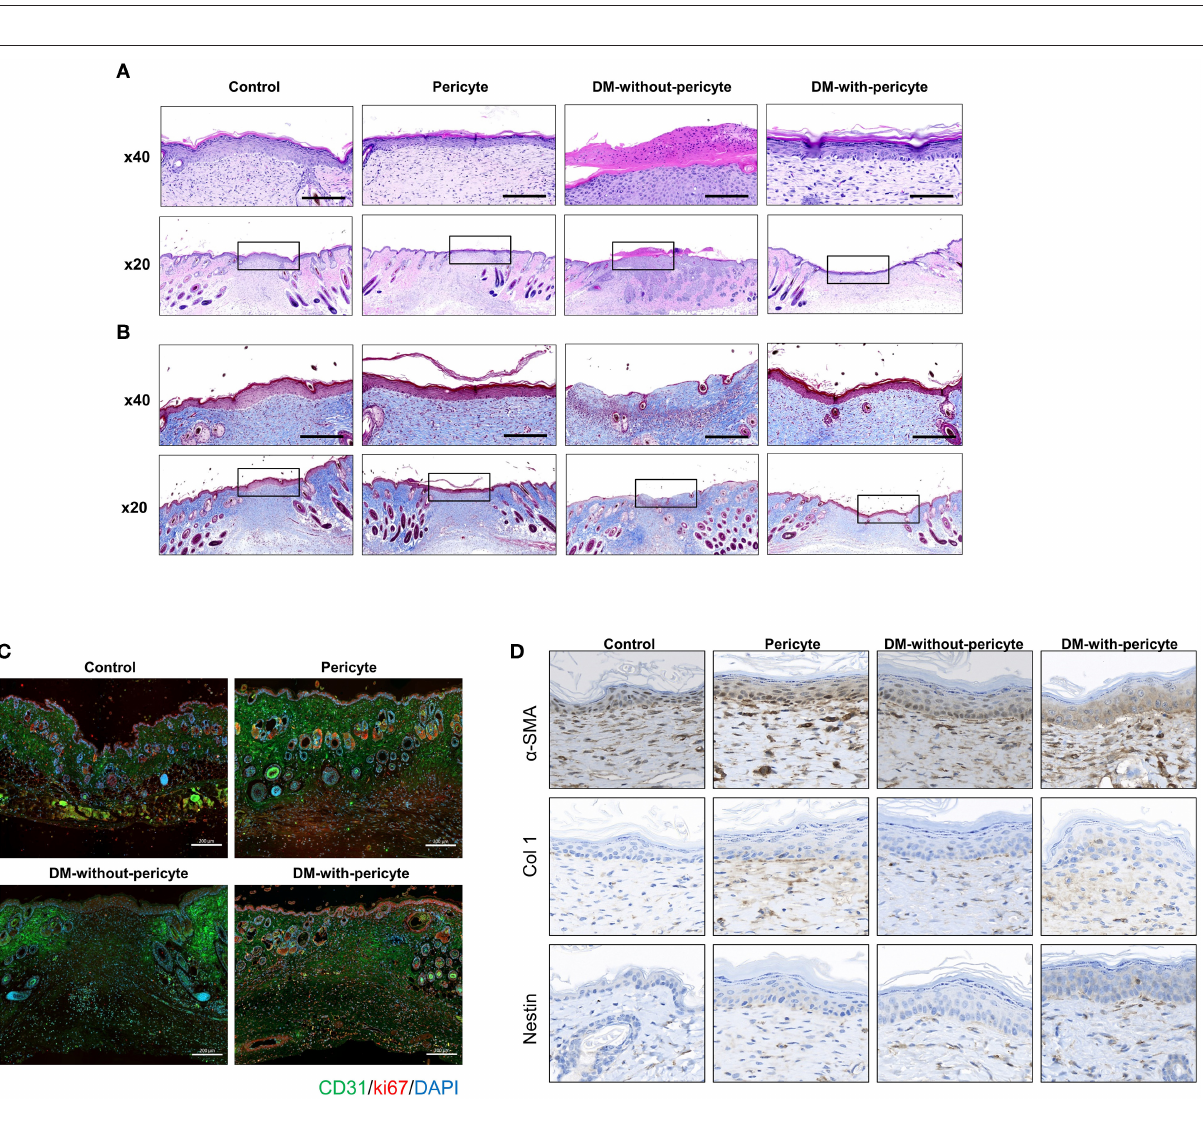
FIGURE 3 | DM-induced mice ( n = 10), control ( n = 10). (C) Incisions with a diameter of 4mm on either side of the midline were produced. To avoid wound contraction, the wounds were circumscribed with donut-shaped silicone splints. As observed on day 7, wounds of the DM-with-pericyte group healed, whereas those of the DM-without-pericyte and control groups did not heal. (D) The Y-axis of the graph represents the wound size, when measured on days 0, 2, 7, and 14. It was verified that all the groups, except the DM-without-pericyte group, had wound closure by the time of sacrifice on day 14 and approximately 3.6mm of the wound of the DM-without-pericyte group remained. The pericyte and DM-with-pericyte groups showed the same wound size on days 0, 2, 7, and 14. (E) Quantification of wound size at sacrifice time points (** P < 0.01). In comparison to the DM-without-pericyte group, the DM-with-pericyte group exhibited substantial wound healing.